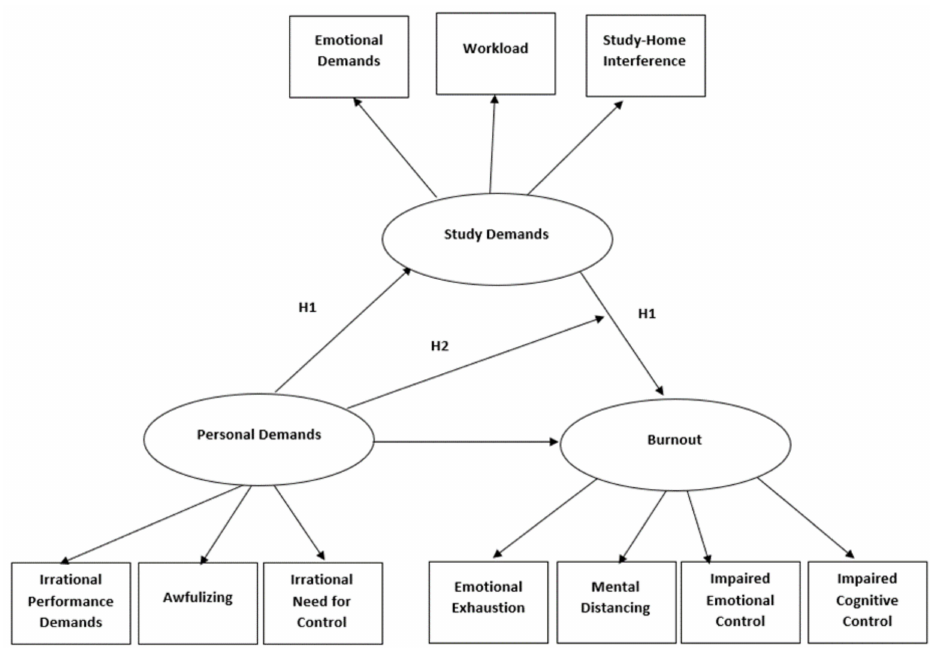
Figure 1. The research model depicting all indicators of the latent